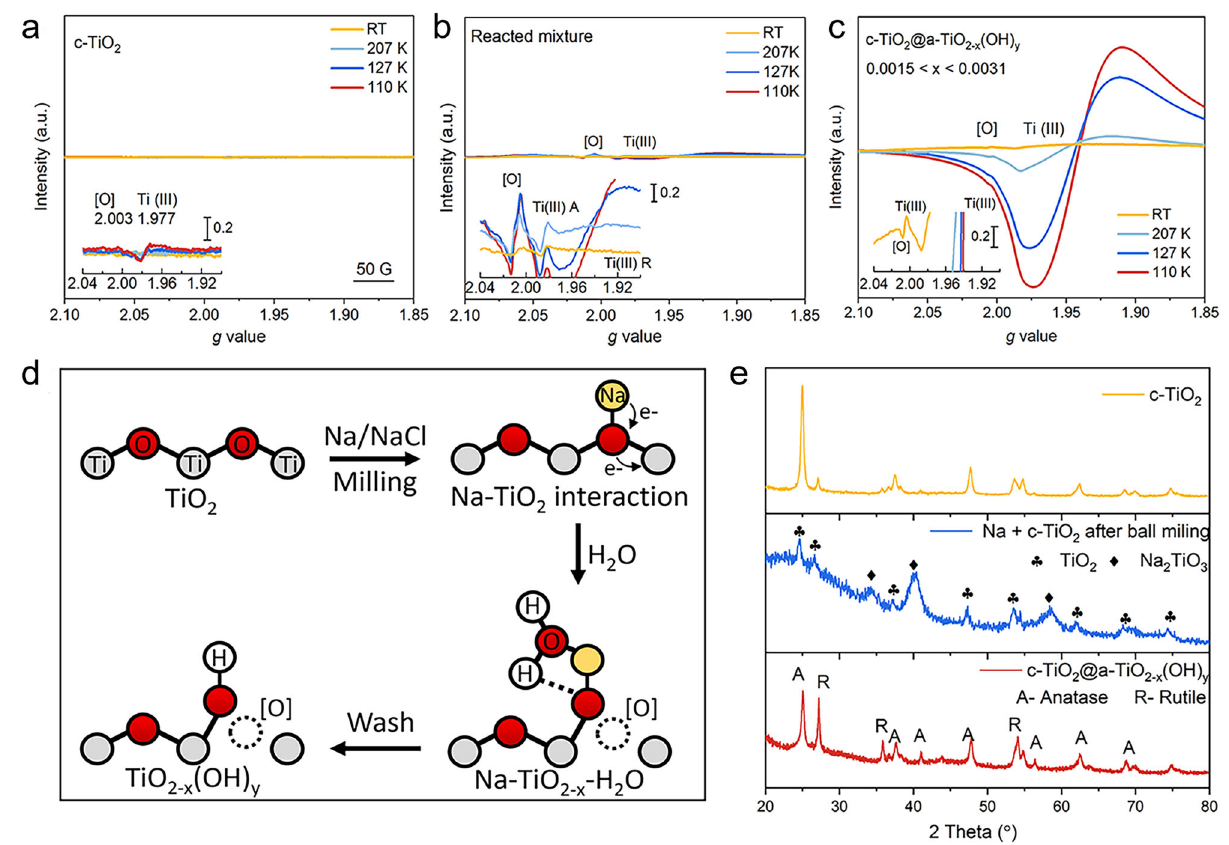
Fig.2|Thepreparationofc-TiO 2 @a-TiO 2-x (OH) y fromc-TiO 2 .a – c EPRspectraof the pristine c-TiO 2 , the mixture of Na+c-TiO 2 +NaCl after ball-milling and the product c-TiO 2 @a-TiO 2-x (OH) y . d Schematic of SFLP formation